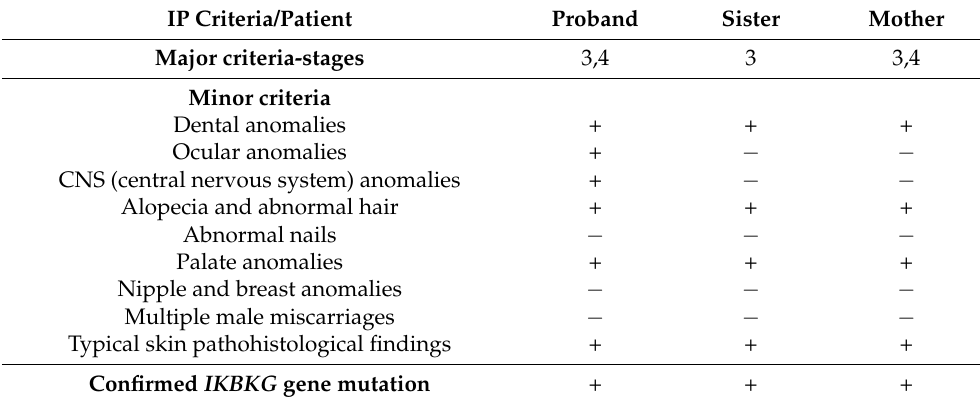
Table 2. Presence of IP diagnostic criteria according to Mini´c et al. [11] in each patient. IP Criteria/Patient Proband Sister Mother Major criteria-stages 3,4 Minor